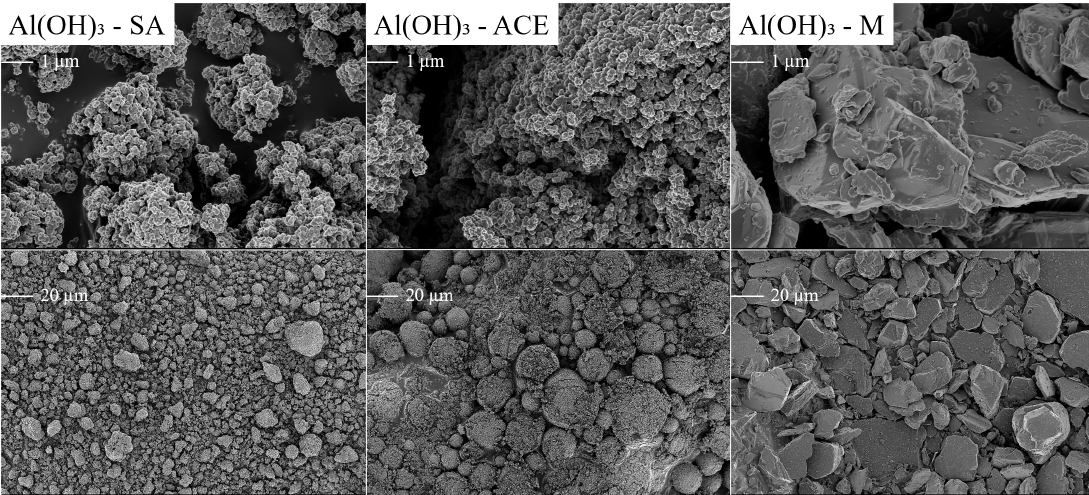
Figure 15. SEM micrographs of the three different Al(OH) 3 sources used from Sigma Aldrich (SA), ACE Chemicals (ACE) and Merck (M) taken at 1keV and 10k (top) and 500 times (bottom) magnification. The scale bar is indicated on each